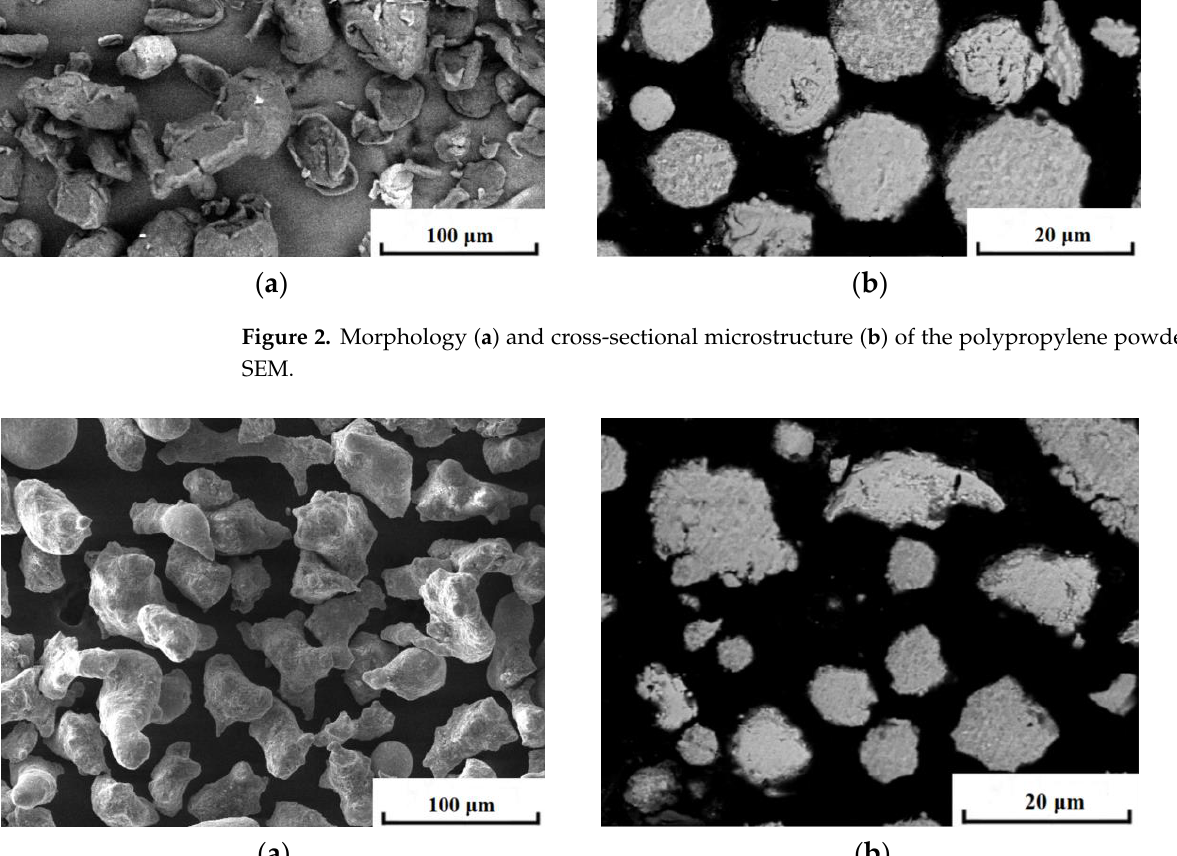
Figure 3. Morphology ( a ) and cross-sectional microstructure ( b ) of Amdry 997 powder by SEM.